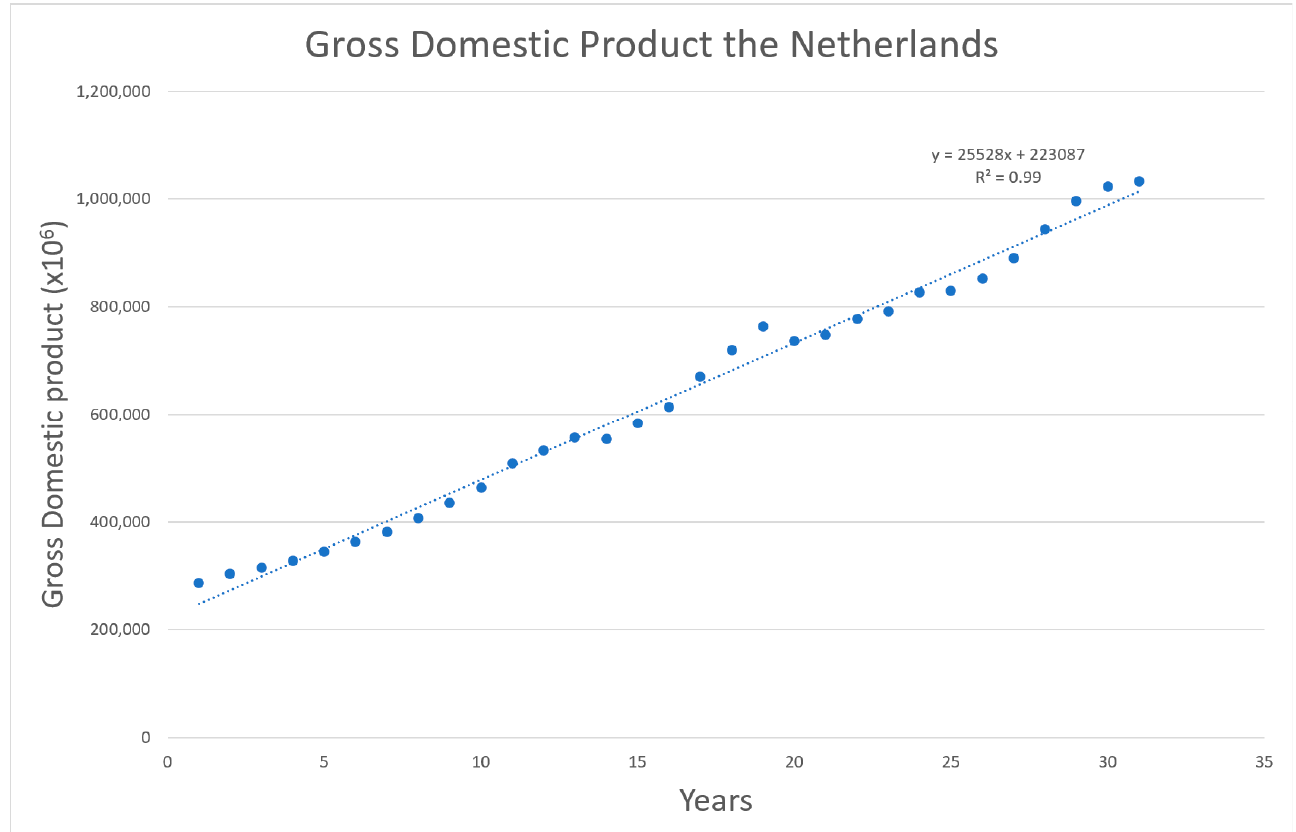
Figure 6. Dutch GDP development over time between 1990 and 2019 [39].